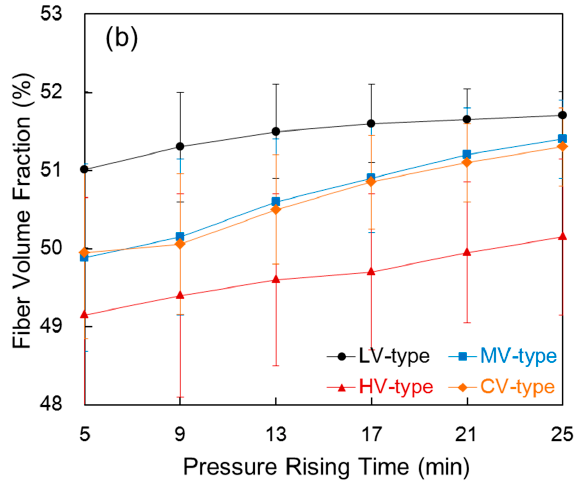
Figure 2. Thickness ( a ) and fiber volume fraction ( b ) of the composite compared with the pressure rising time in each film stacking type.